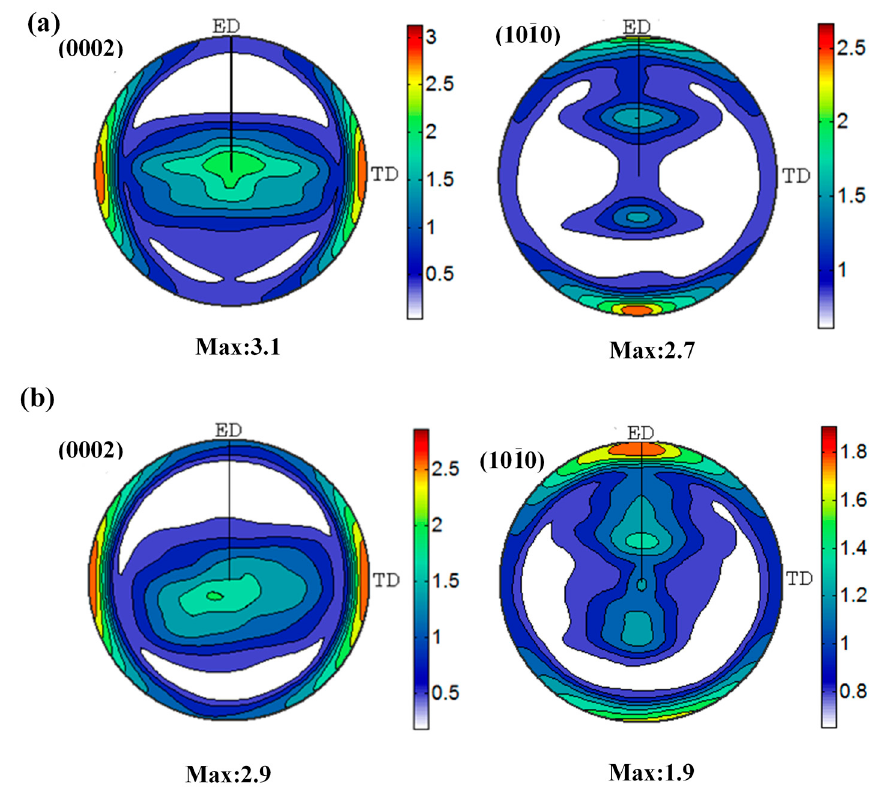
Figure 5. The (0002) and (1010) pole figures of extruded TZA822 alloys. ( a ) Without T4 and ( b ) with T4, respectively.